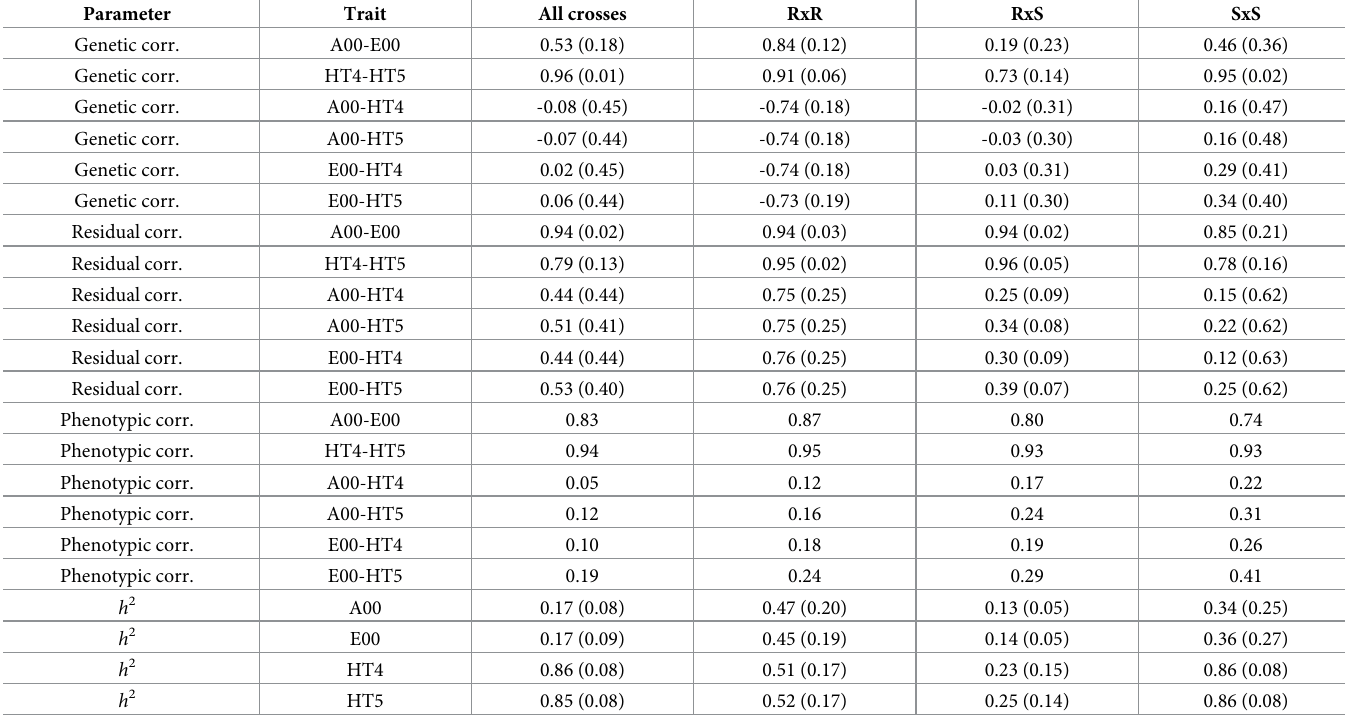
Table 2. Genetic parameters (correlations; genetic control) were estimated for each cross-type in interior spruce.